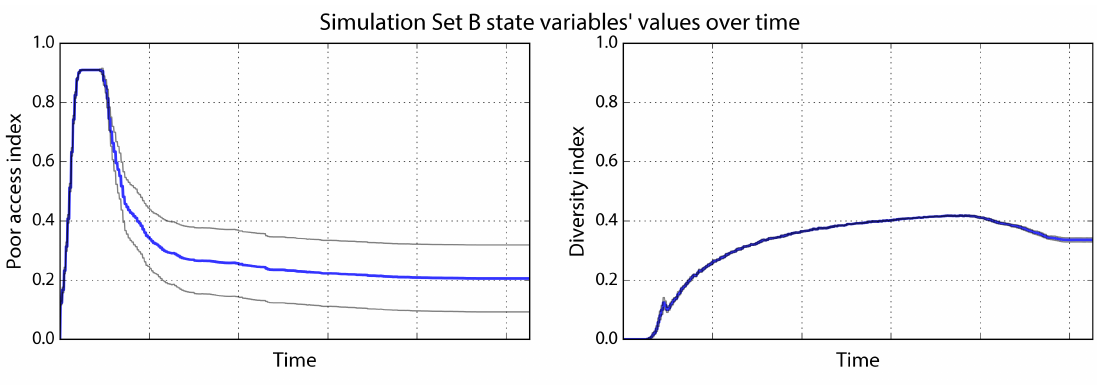
Figure 4. Set B’s state variables from initialization through the end of the simulation, with mean value (blue) and 95% confidence interval (gray) across 50 runs.